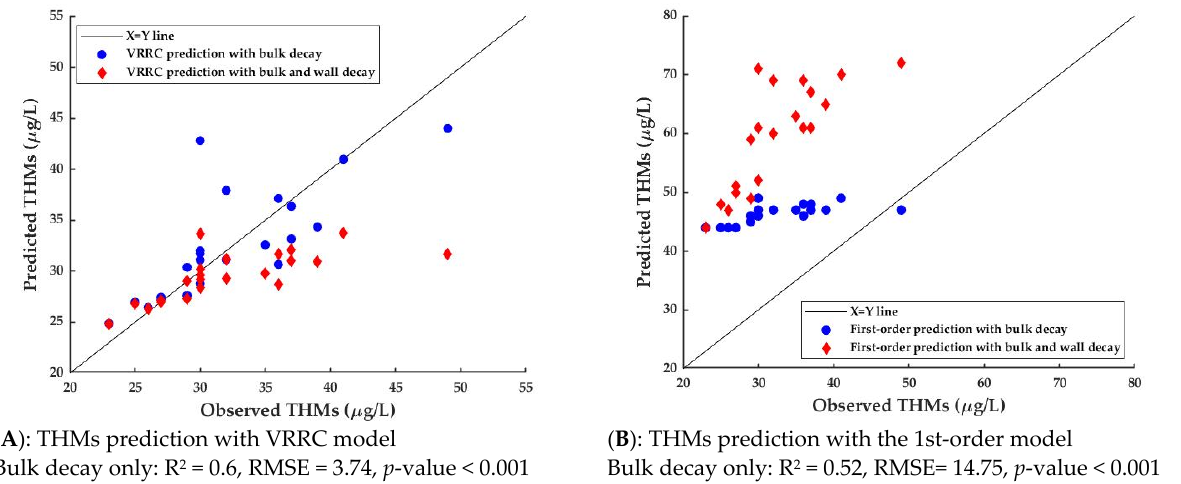
Figure 6. THMs prediction results and goodness of prediction in the DS; comparison between the VRRC and the 1st-order models.